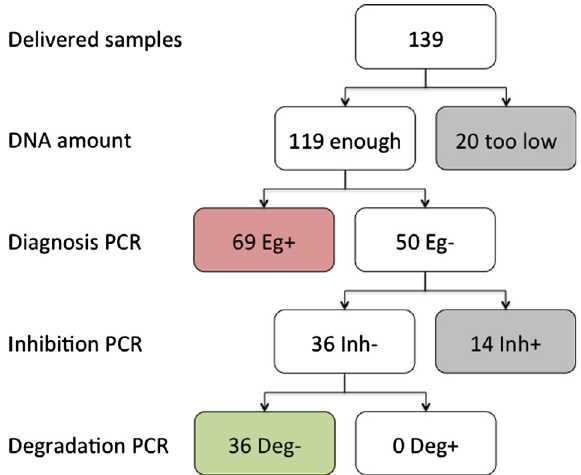
Figure 5. Sequential diagram of sample treatment. Numbers of samples at different steps of their treatment are presented, in particular results from the detection of Entamoeba gingivalis by PCR (‘‘Eg+’’ stands for positive results; ‘‘Eg (cid:2) ’’, for negative results), the presence or absence of inhibitors (‘‘Inh (cid:2) ’’ and ‘‘Inh+’’, respec- tively), and degradation or not of DNA (‘‘Deg+’’ and ‘‘Deg (cid:2) ’’,